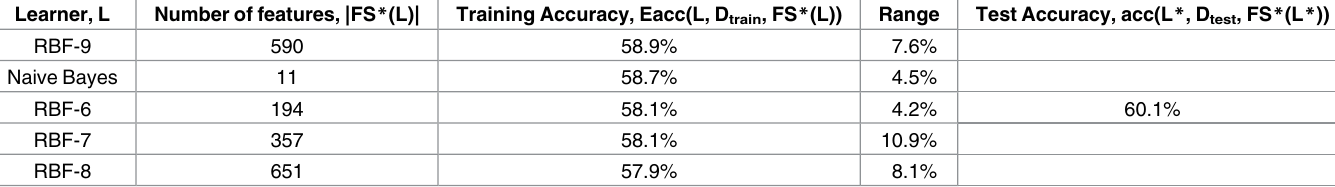
Table 8. ABIDE, structural images.